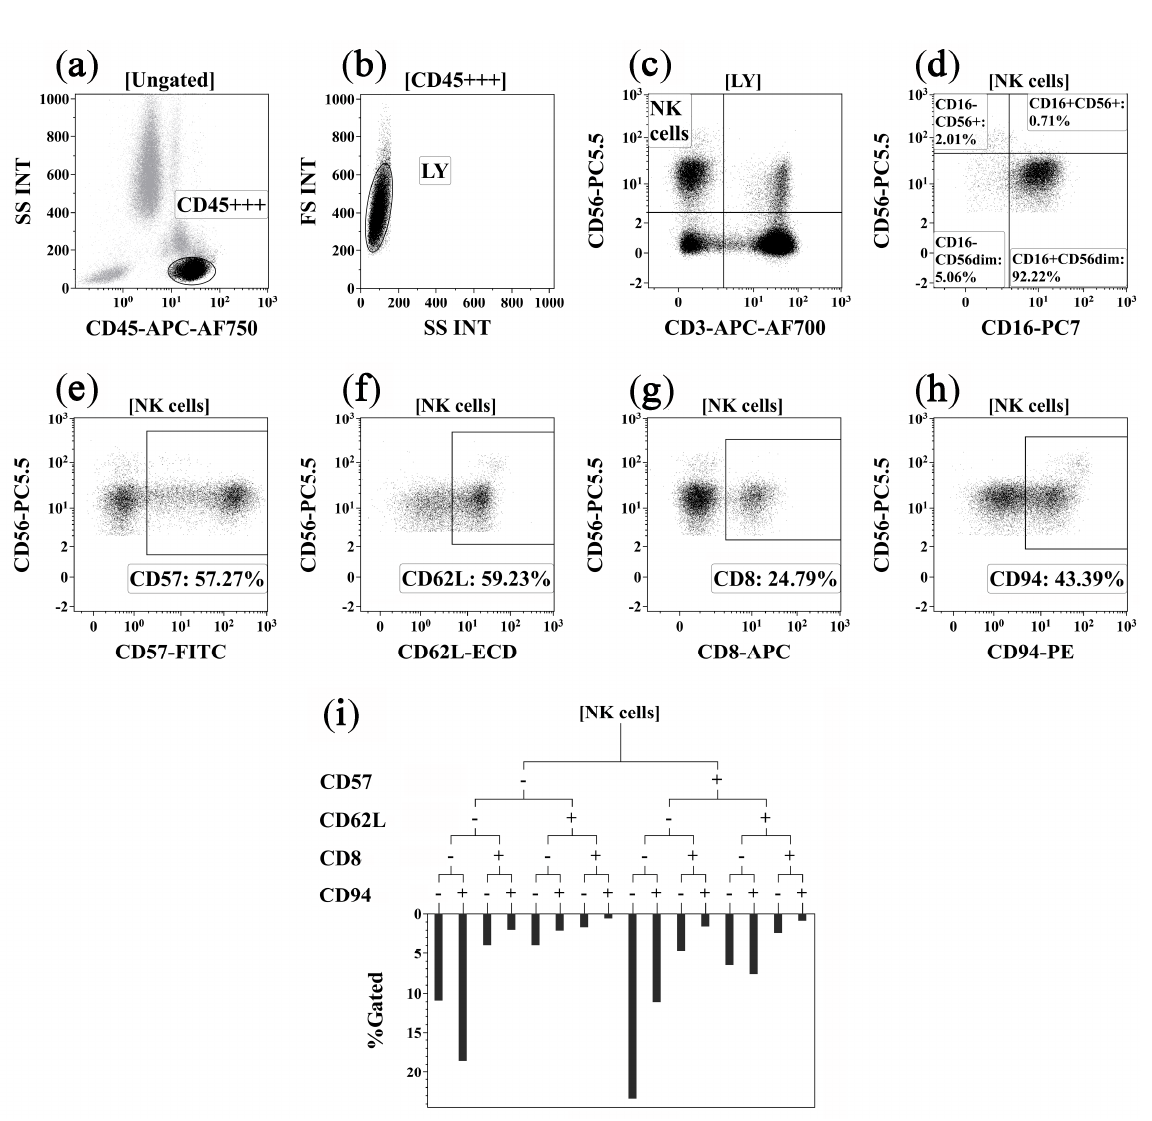
Figure 3. Flow cytometry immunophenotyping gating strategy for NK cell subsets. ( a ) Total lym- phocyte subset identification based on side scatter and bright CD45 expression; ( b ) discrimination between single lymphocytes, doublets, and cell debris; ( c ) total NK cell subset was detected as CD3 − CD56 + ; ( d ) co-expression of CD16 and CD56 on main NK cell subsets, including CD16 + CD56 + , CD16 − CD56 + , CD16 + CD56 dim , and CD16 − CD56 dim NK cells; ( e – h ) expression of CD57, CD62L, CD8, and CD94 by NK cells, these gates were used as branches for the hierarchical tree histogram; ( i ) hierarchical tree histogram was gated on total NK cell subsets as an example. The frequency histogram below the trees indicated the relative proportion of cells with different patterns of CD57, CD62L, CD8, and CD94 co-expression within total NK cells.